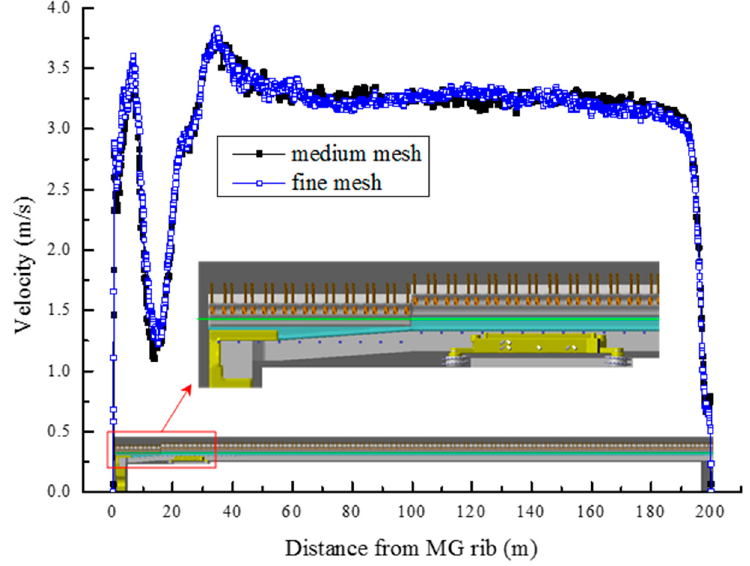
Figure 3. Velocity profiles along the face in the walkway—2 m above floor.